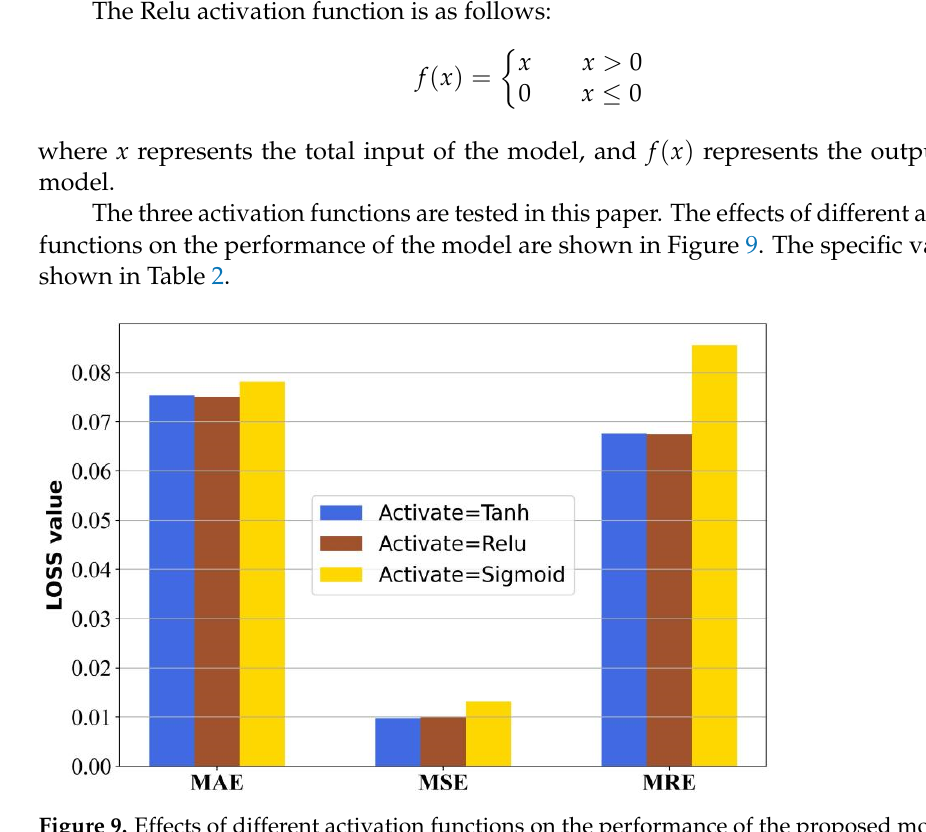
Figure 9. Effects of different activation functions on the performance of the proposed model at A 1. (MSE and MAE are in units of 0.1xTECU). Table 2. Activation function’s influence at A 1.